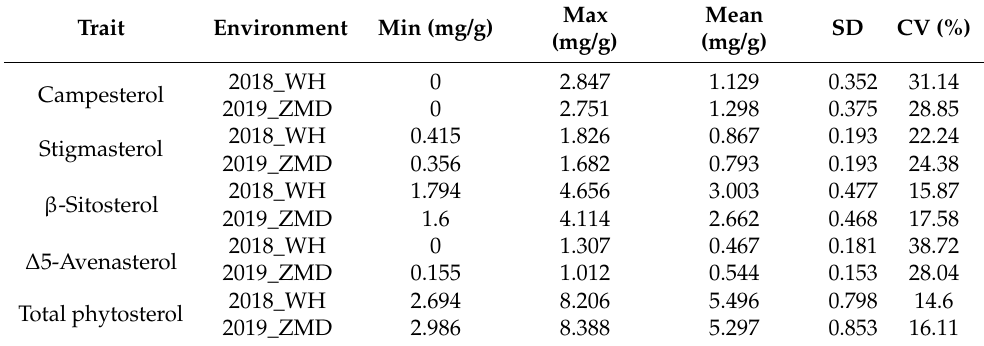
Table 1. Variation of primary phytosterol contents in sesame